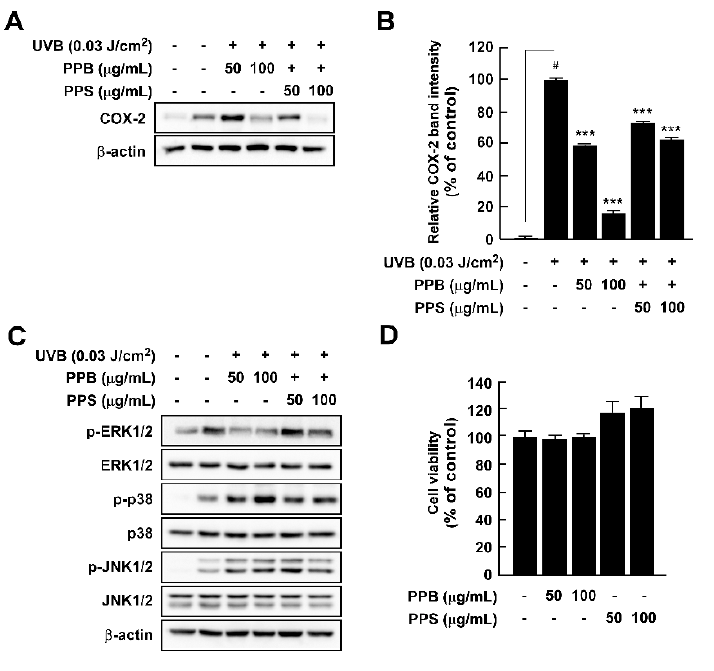
Figure 4. Effects of pink pepper extract (PPE) on UVB-induced COX-2 expression and MAPK phosphorylation in HaCaT cells. ( A ) PPE suppressed UVB-induced COX-2 expression in HaCaT cells. Cells were treated with the indicated concentration of PPE for 1 h and then stimulated with UVB (0.03 J/cm 3 ) for 4 h. ( B ) Quantification of COX-2 expression by PPB and PPS. ( C ) PPE suppressed UVB-induced phosphorylation of ERK1/2, but not p38 and JNK1/2. Cells were treated with PPE for 1 h and then stimulated with UVB (0.03 J/cm 3 ) for 30 min. ( D ) PPB and PPS did not affect the cell viability at the tested concentrations. The cells were treated with increasing concentration of PPB and PPS for 24 h. Phosphorylated MAPK and COX-2 expression were detected by Western blot. Data are presented as mean ± standard deviation of three independent experiments. # p < 0.05 between control and LPS-exposed cells (no PPE); *** p < 0.001.